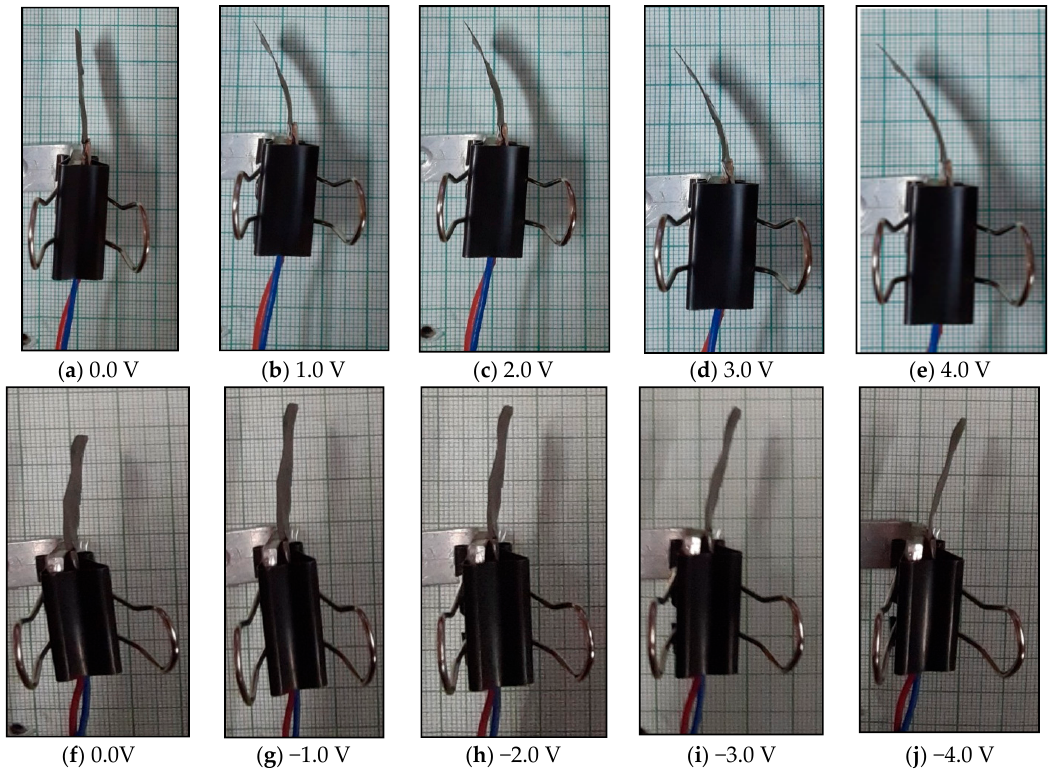
Membranes 2022 , 12 , 651 Figure 3. Step-by-step bidirectional deflection behavior of the SPVC–PTA–Pt actuator.